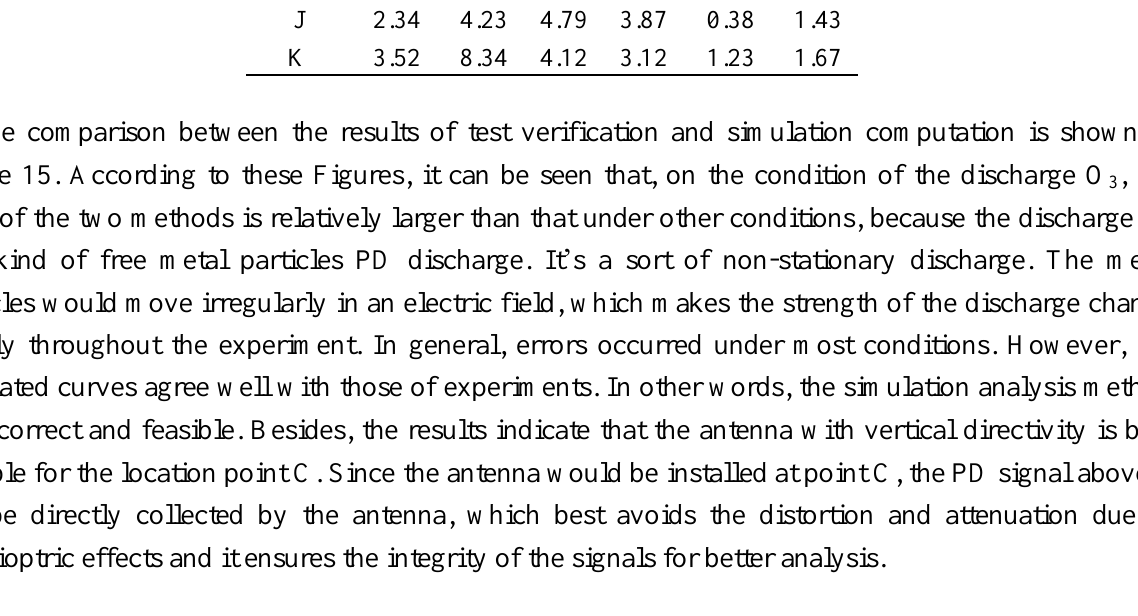
Table 6. Amplitude field strength of each detection point (normalized).